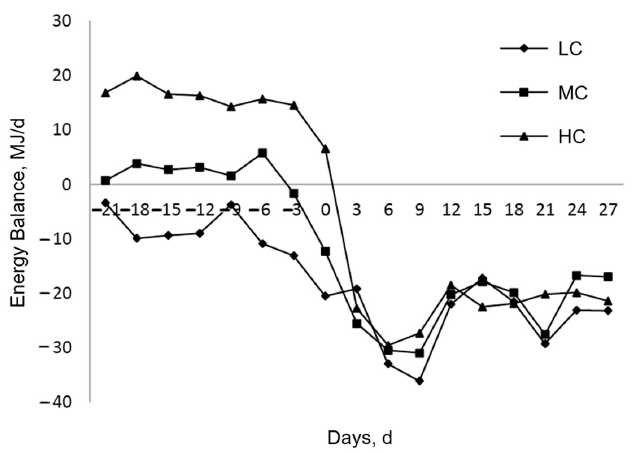
Figure 1. Effects of prepartum dietary concentrate levels on the energy balance of dairy cows. LC: low concentrate (0.3% of body weight), MC: medium concentrate (0.6% of body weight), HC: high concentrate (0.9% of body weight).